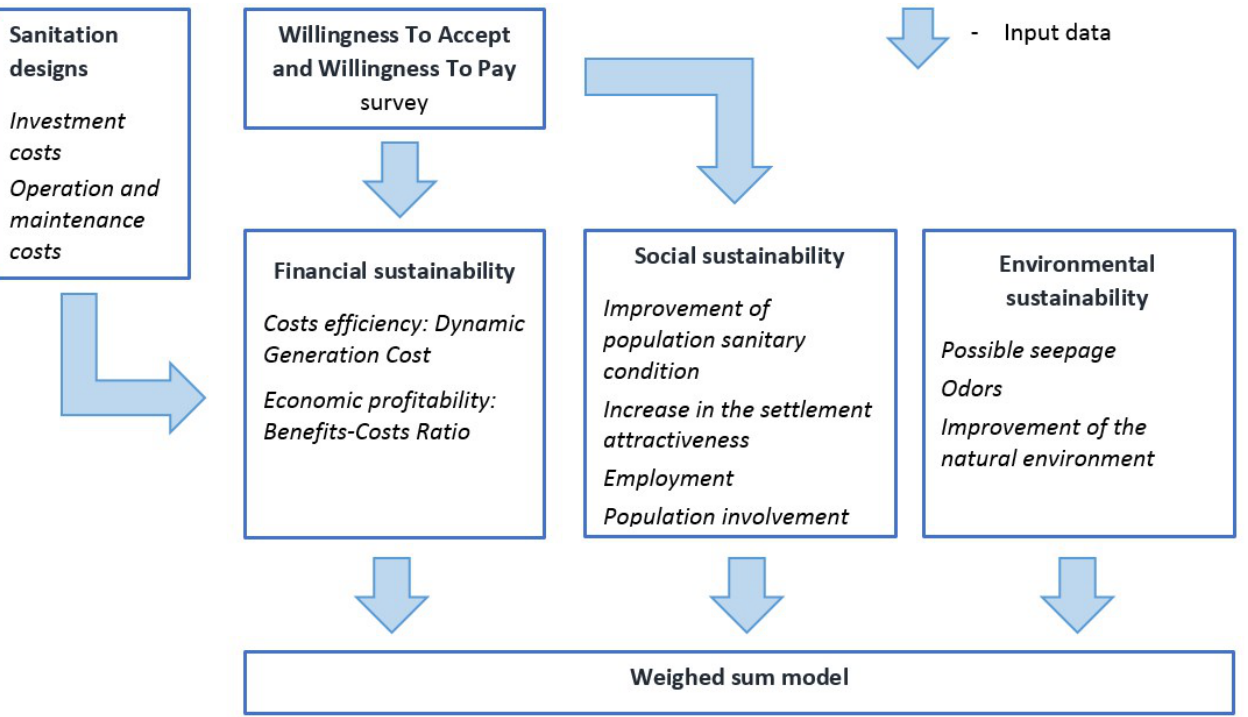
Figure 2. Scheme of assumed methodology of research.